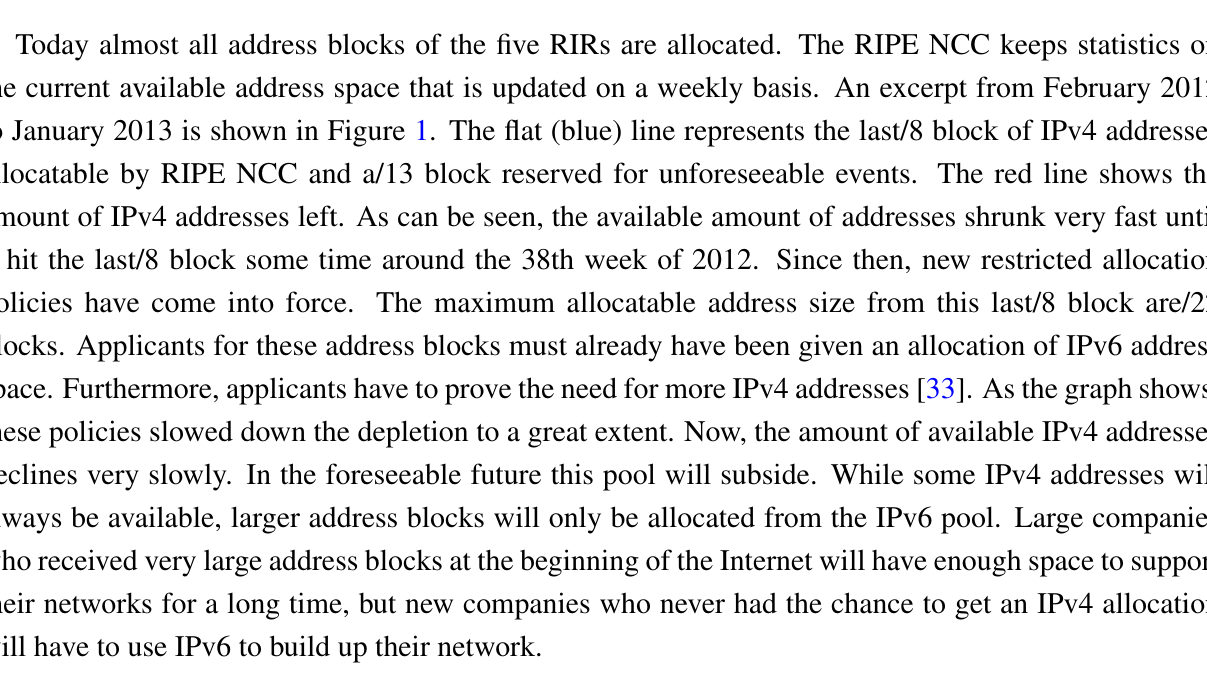
Figure 1. Depletion of Internet Protocol (IPv4) from February 2012 to January